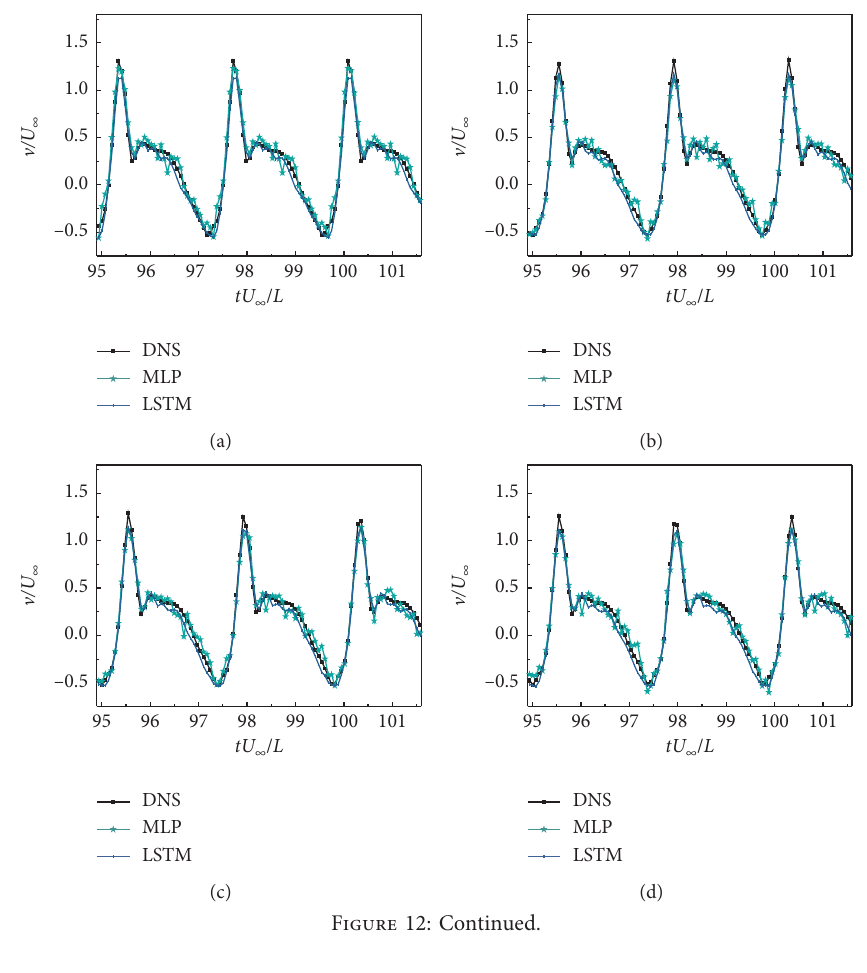
Figure 11: The reconstructed velocity field by DNS and deep learning frameworks at Ma � 0.6. (a) DNS ( tU L � 101.57), (c) MLP ( tU ∞ / L � 98.26), (d) MLP ( tU ∞ / L � 101.57), (e) LSTM ( tU ∞ / L � 98.26), and (f) LSTM ( tU ∞ / L �